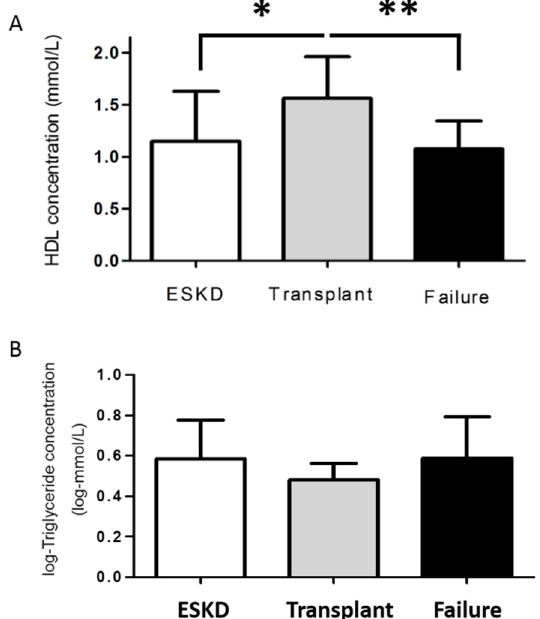
Figure 2. Average HDL ( A ) and triglyceride ( B ) concentrations according to kidney function for patients that experienced graft failure. Value are displayed as mean ± standard deviation. To convert values HDL to mg/dL, multiply by 38.67. To convert values for triglycerides to mg/dL, multiply by 88.57. * p = 0.001. ** p < 0.01. Abbreviations: HDL, high density lipoprotein.